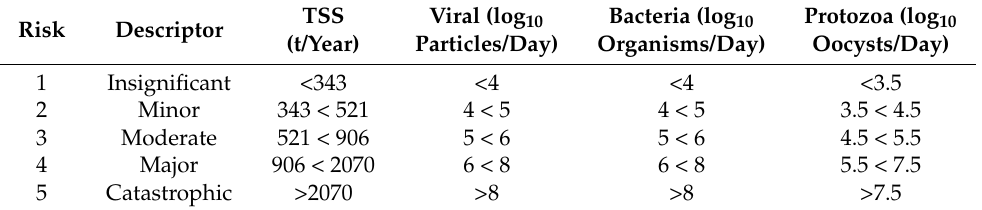
Table 4. Example water treatment plant lookup table for treatment capability